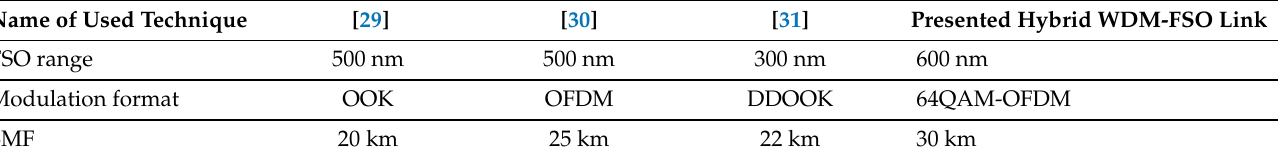
Figure 5. WDM-FSO transmission range as a function of Q-factor estimations. Table 2. Comparison estimations of presented hybrid WDM-FSO link with current